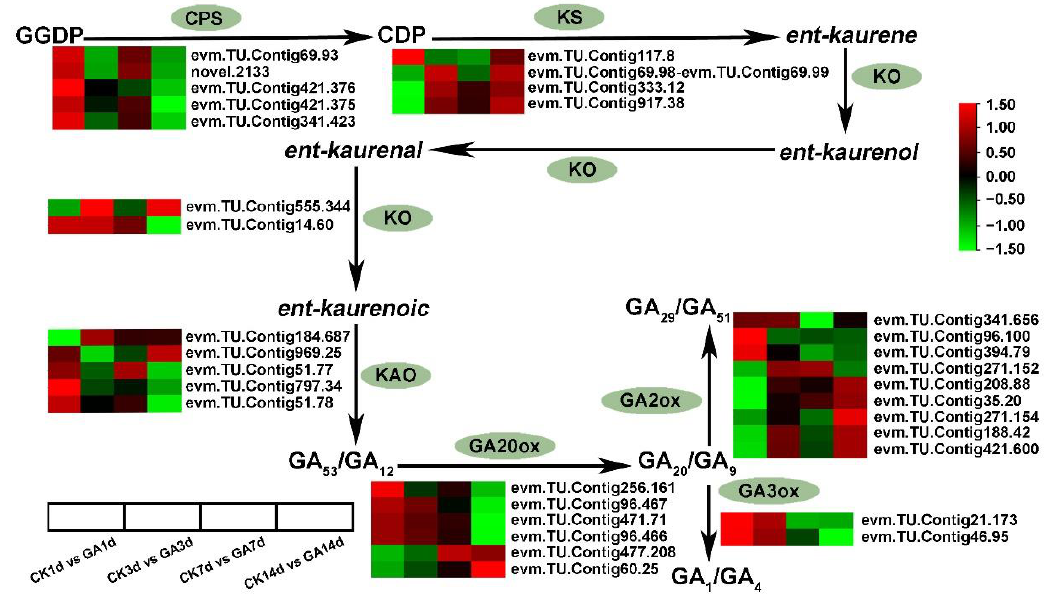
Figure 4. Simplified schematic diagram and DEGs heatmap analysis of GA biosynthesis. The GA biosynthesis components are marked with green background. Data is shown in log2 (Fold Change) analysis. Heatmap of rows and columns represent genes and samples, respectively. CPS, ENT-COPALYL DIPHOSPHATE SYNTHASE; KS, ENT-KAURENE SYNTHASE; KO, ENT-KAURENE OXIDASE; KAO, ENT-KAURENOIC ACID OXIDASE; GA20ox, GA − 20 oxidase; GA2ox, GA − 2 oxidase; GA3ox, GA − 3 oxidase.